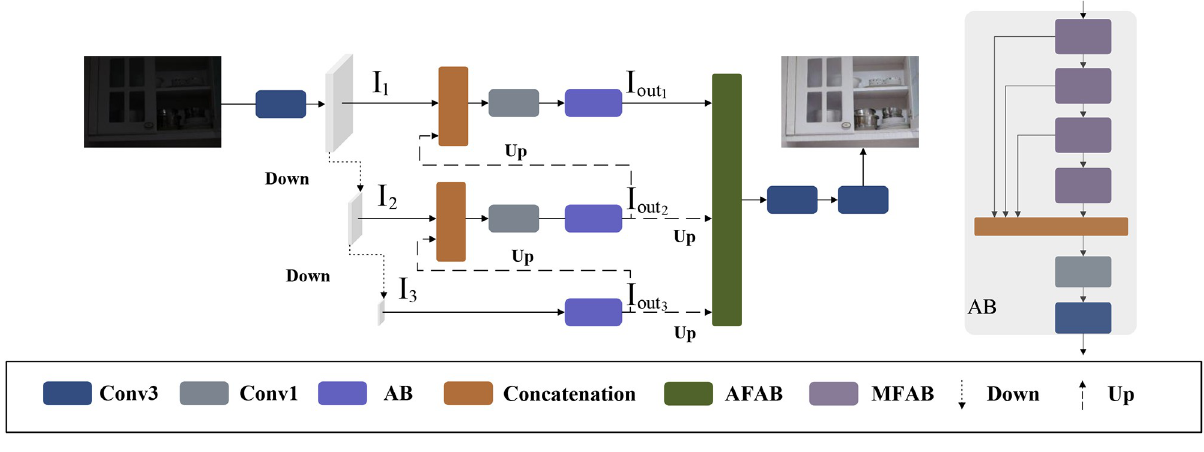
Fig 1. The structure of our proposed